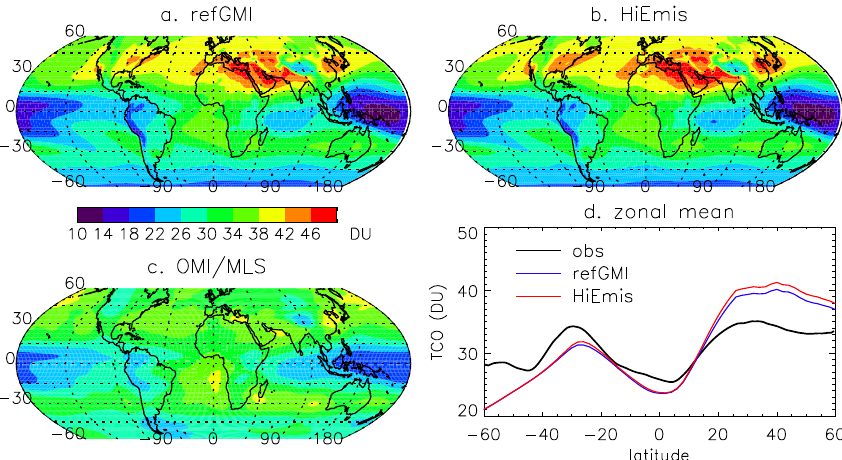
Figure 9. Annual mean tropospheric column ozone (TCO) from the RefGMI (a) and GMI-HiEmis (b) simulations compared to the OMI/MLS TCO product (c) of Ziemke et al. (2011). Panel (d) compares the zonal mean simulated and OMI/MLS values. The simulated values are averaged over the years of the time slice (1999–2009). Table 4. NH / SH OH ratio and percent changes in tropospheric OH concentrations and lifetimes against tropospheric OH for the CO–OH sensitivity studies compared to the RefCO–OH simulation. SensTCO SensStO3 SensQ SensNOx SensAll NH / SH